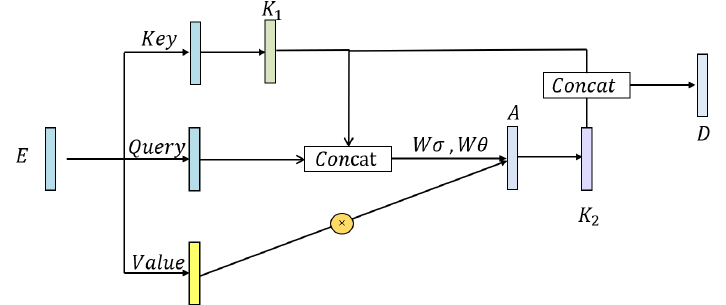
Figure 3. Structure of CoT